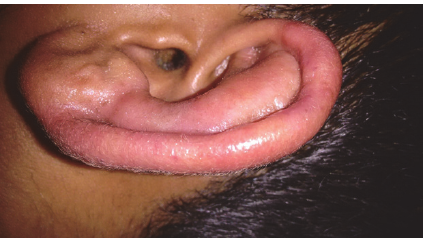
Figure 2: Redness and swelling of cartilaginous upper two-thirds of the external